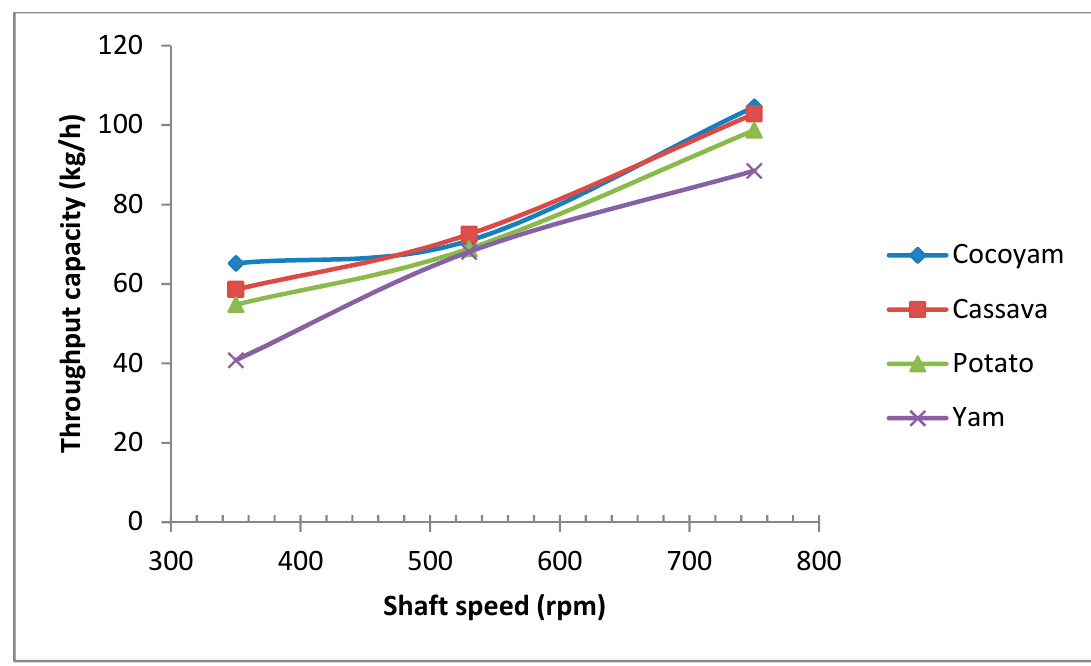
Figure 10. Effect of shaft speed on the throughput capacity. Figure 10. E ff ect of shaft speed on the throughput capacity. Table 6. E ff ect of shaft speed on the peeling e ffi